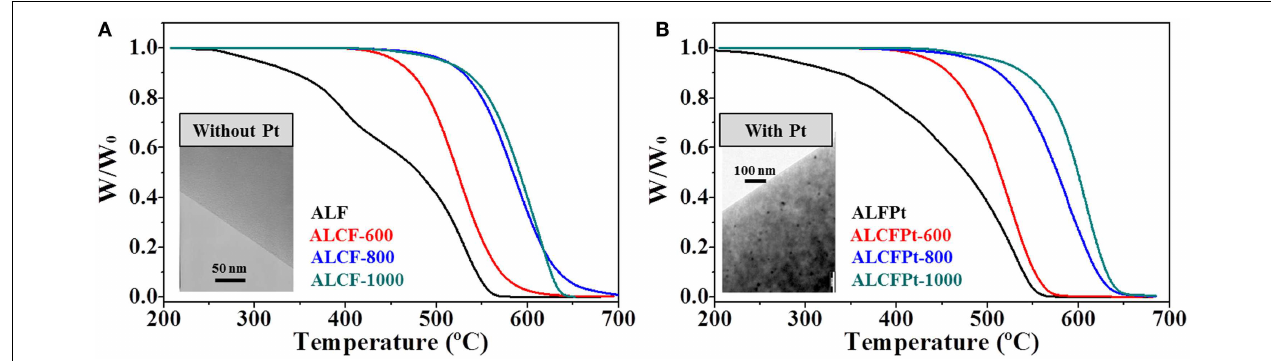
FIGURE 7 | Oxidation resistance profiles in air atmosphere of non-stabilized and carbonized lignin-derived CFs (A) without platinum and (B) with platinum adapted from Ruiz-Rosas et al. (2010)